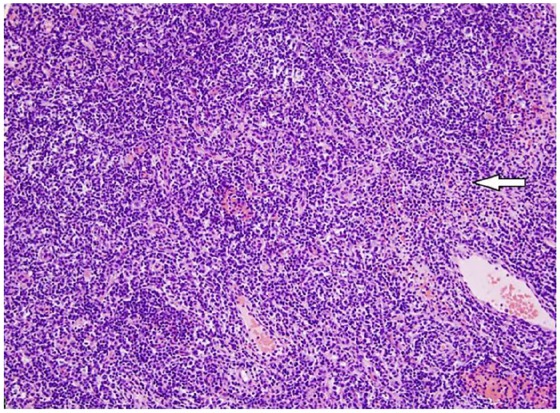
Low-power field (20×; hematoxylin-eosin) with arrow pointing to rich
lymphoplasmacytic infiltrate on axillary lymph node biopsy.